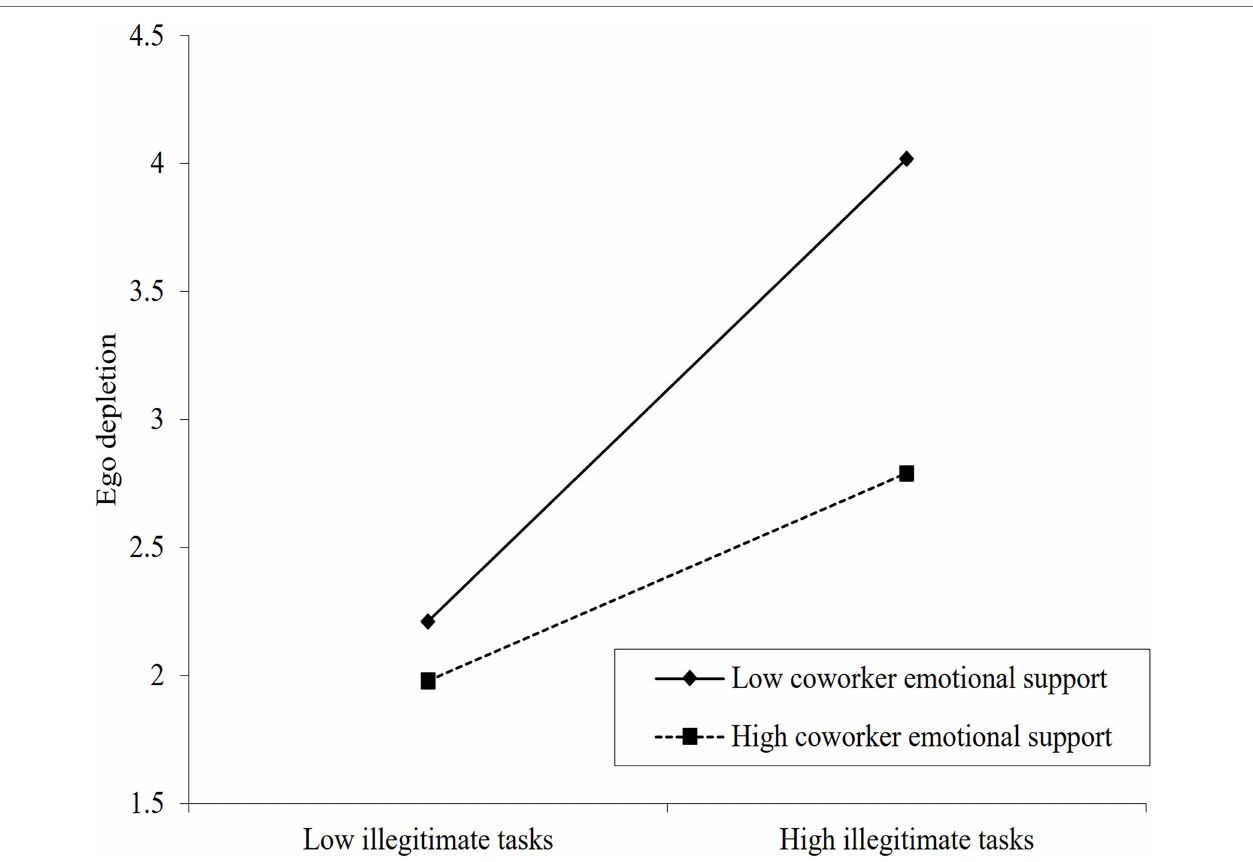
FIGURE 2 | Moderating effect of coworker emotional support on relationship between illegitimate tasks and ego